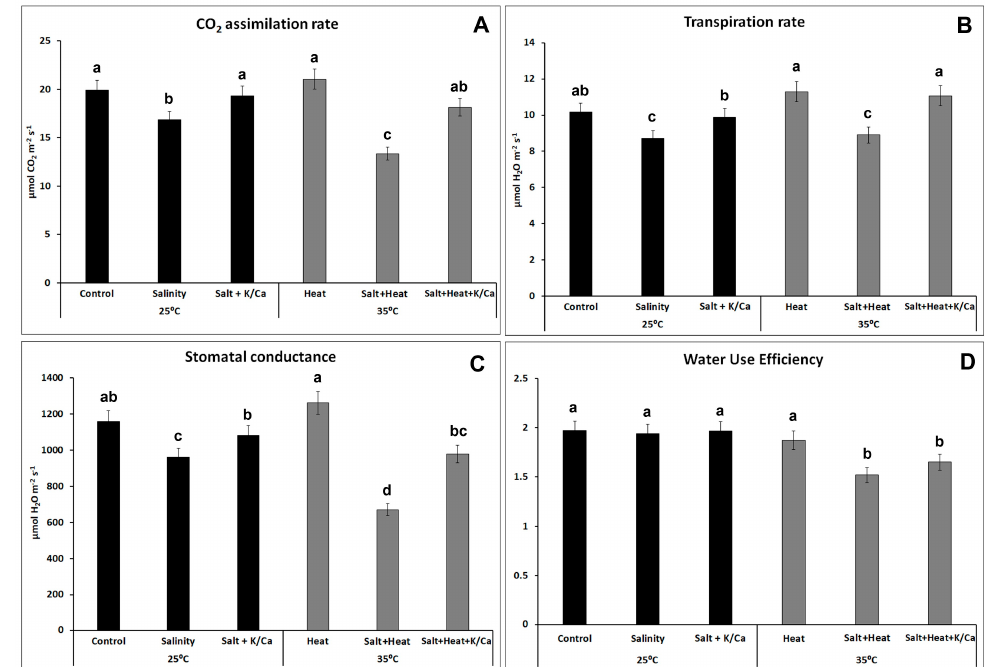
Figure 3. Photosynthetic parameters in tomato leaves grown under control, salinity (60 mM NaCl or salinity combined with higher K + and Ca 2+ concentration in the irrigation solution at optimal temperature (25 °C) or heat stress (35 °C). Values are means ± SE ( n = 6). Bars with different letters within each panel represent data with significant differences at p < 0.05 (Tukey HSD).